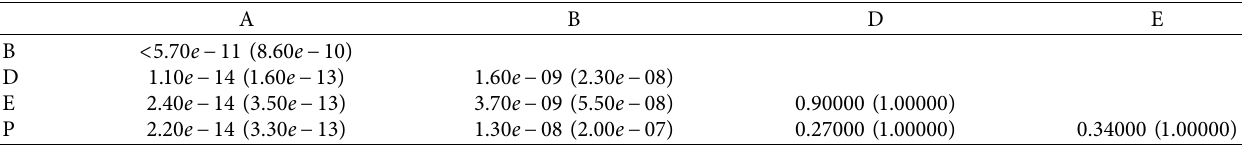
Figure 7: In L-Space for (a) TransAntofagasta, (b) Linja-Karjala Oy, (c) CIT, and (d) Thunder Bay Transit. pI � 0.05, pR � 0.0025, and T � 65 (boxplot diagram for A, B, D, E, and P groups). Table 7: In L-Space, for BC Transit network, pI � 0.05, pR � 0.0025, and T � 150, p -value of the Wilcoxon rank sum test (resultant p -value per Bonferroni correction is indicated in brackets).